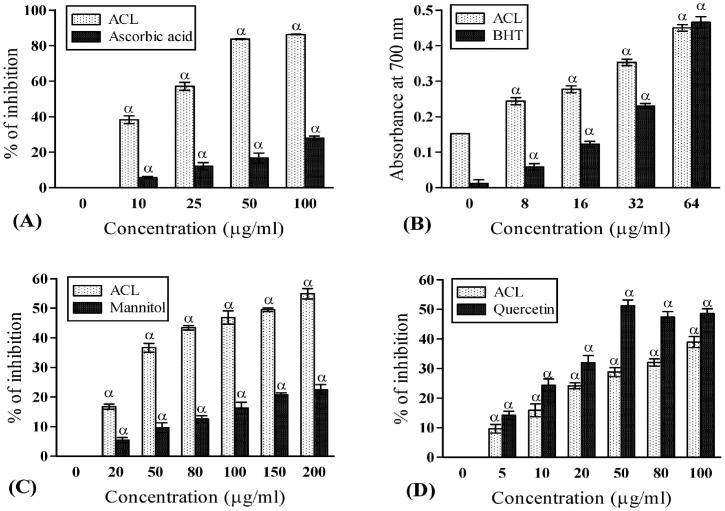
Antioxidant and free-radical scavenging activities of ACL extract.(A) DPPH radical scavenging activities of ACL extract and standard ascorbic acid (IC50 value: ACL = 15.52±0.46μg/ml and ascorbic acid = 240.10±28.35 μg/ml; p<0.001). (B) Total reductive abilities of ACL extract and standard butylated hydroxytoluene (BHT). The absorbance (A700) was plotted against concentration of sample; higher absorbance value signified greater reducing capacity. (C) Hydroxyl radical scavenging capacities of ACL extract and standard mannitol (IC50 value: ACL = 121.20±1.22μg/ml and mannitol = 589.06±46.57μg/ml; p<0.01). (D) Superoxide radical scavenging activities of ACL extract and standard quercetin (IC50 value: ACL = 131.900±4.40μg/ml and quercetin = 63.93±4.16μg/ml; p<0.01). [Each value represents mean ±SD (n = 6); Where, α = p<0.001 Vs 0 μg/ml].